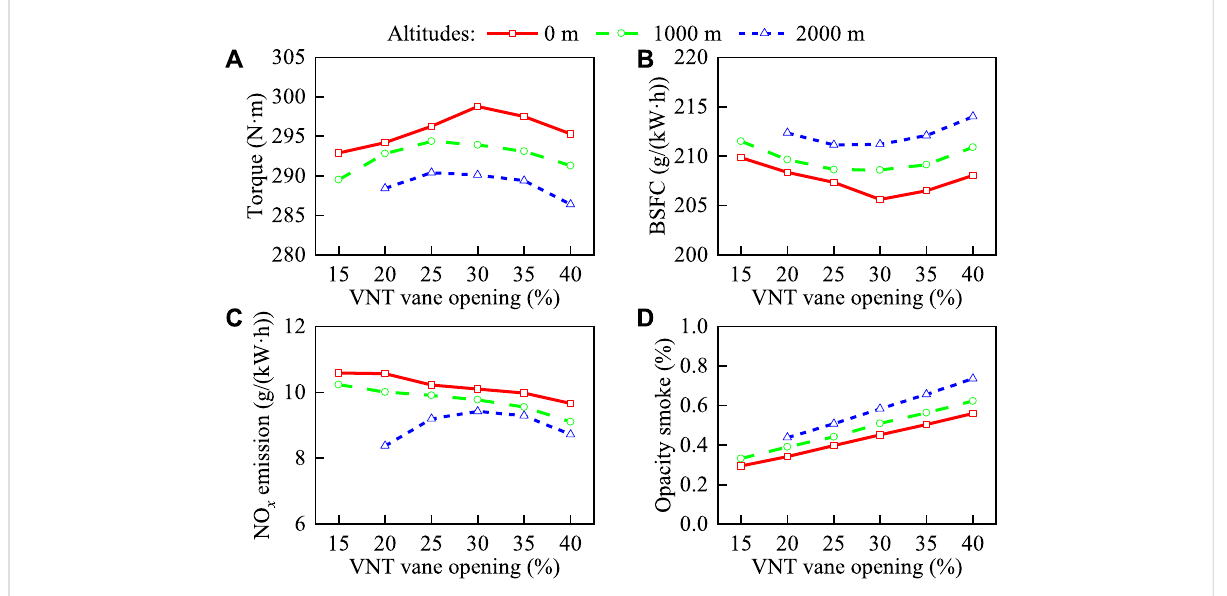
FIGURE 13 Impacts of VNT vane opening on engine performance and emissions, (A) torque, (B) BSFC, (C) NOx emission and (D) opacity